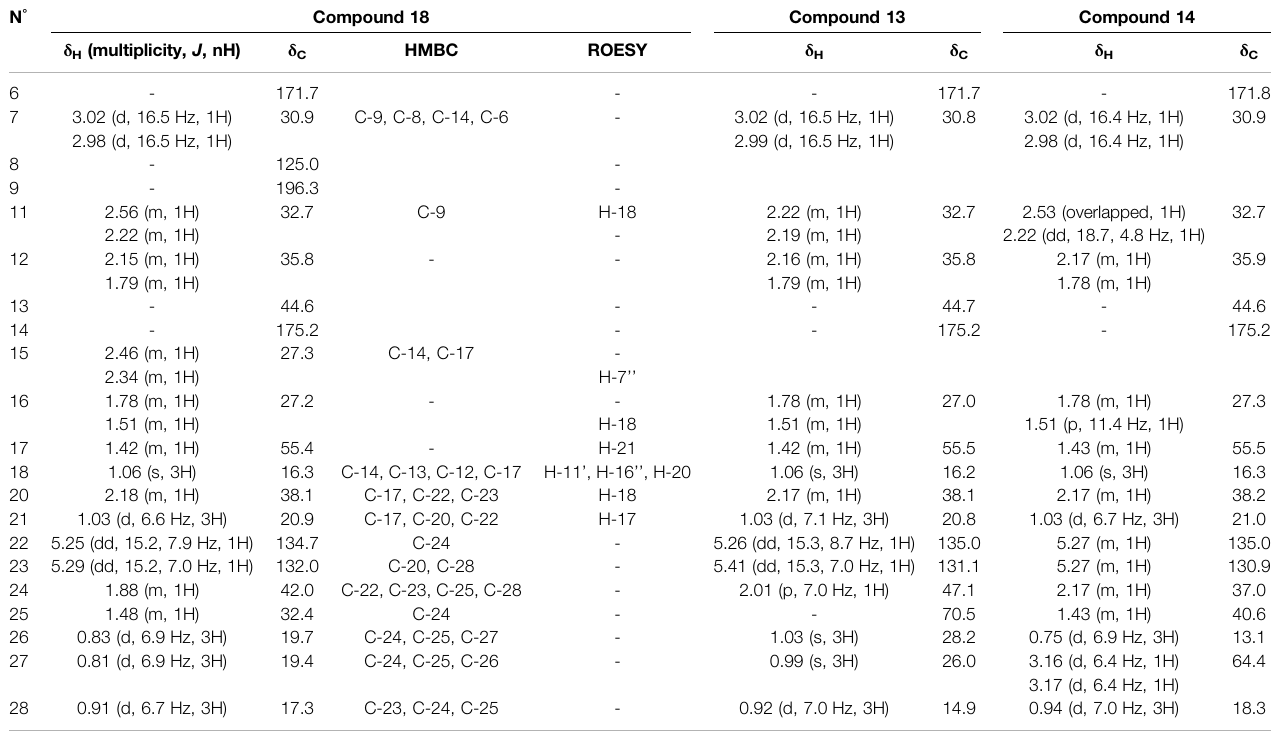
TABLE 5 | NMR chemical shifts of compound 18 , 13, and 14 in DMSO- d 6 at 600 MHz. N